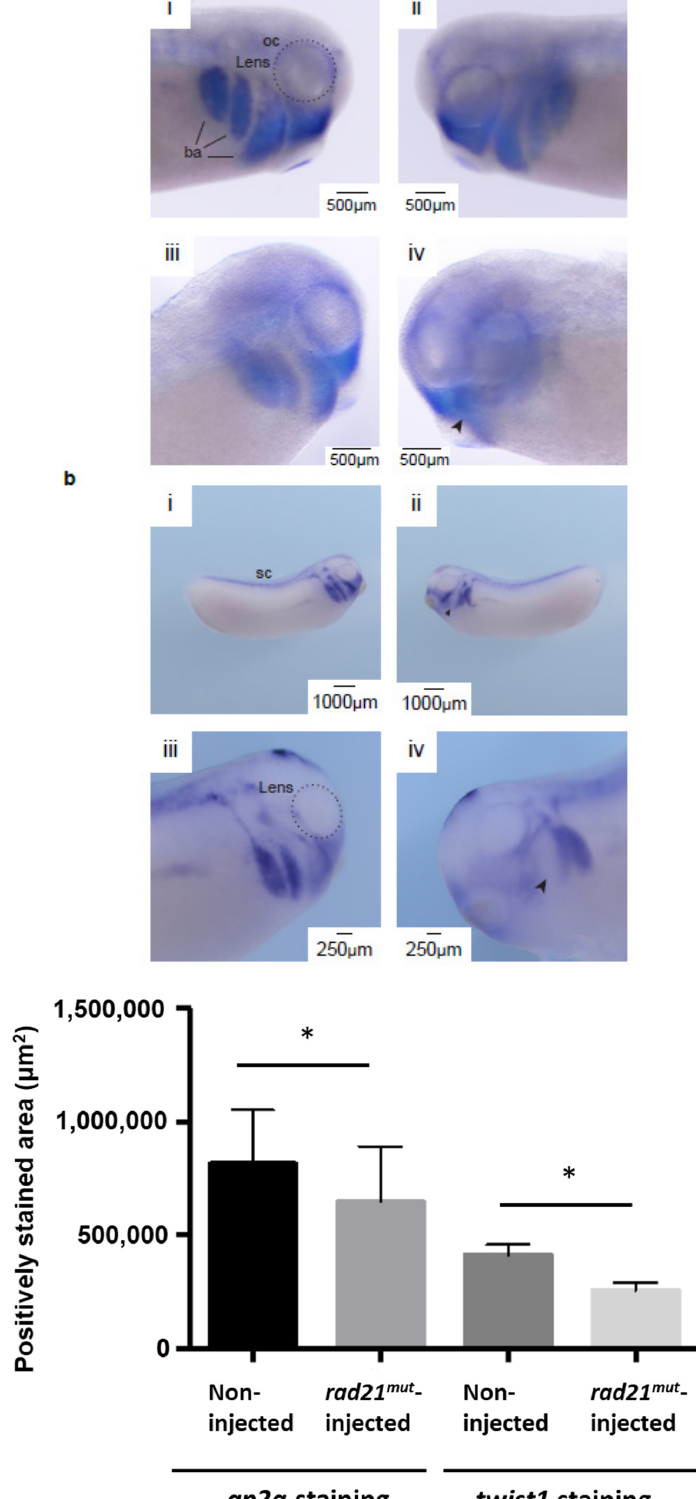
Figure 3. rad21 mut disrupts the migration of neural crest cells (NCCs) in stage-25 Xenopus laevis . ( a ) The in situ hybridization pattern of twist1 was altered in the rad21 mut -injected side. Panel i and ii show twist1 expression on both sides of the same non-injected embryo. The patterns around the optic cup (oc) and the neural crest migration streams into branchial arches (ba) are intact (indicated by a dash circle and dark solid lines, respectively). Panel iii and iv show the non-injected side and the injected side of the same rad21 mut - injected embryo. The optic cup and branchial arch in panel iii are similar to those in panel i and ii, whereas these patterns are disrupted in panel iv. A total of 20 rad21 mut - injected embryos were used, and 18 of them showed disrupted patterns in the rad21 mut - injected side (18/20). ( b ) The in situ hybridization pattern of ap2a is altered in rad21 mut -injected X. laevis embryos. Panel i shows ap2a is highly expressed in the head region and the spinal cord (sc) in the non-injected side. Panel ii shows the ap2a expression pattern is disrupted in the rad21 mut -injected side. Panel iii and iv show higher magnifications of the non-injected side and rad21 mut -injected side of another embryo. Similar to panel ii, disrupted neural crest migration streams are shown in panel iv. A total of 11 rad21 mut - injected embryos were used, and 9 showed disrupted staining patterns in the rad21 mut -injected side (9/11, arrowhead). ( c ) Quantification of the mandibular areas showing positive staining of ap2a and twist1 . Means and standard deviations for three injected sides were analyzed in each group. Statistics was done by using paired t test; * indicates p < 0.05. 2.4. Decreased Periocular Mesenchymes Invading into the Cornea in rad21 mut -Injected X. laevis Embryos Proper cell migration of periocular mesenchymes (POM) is essential for the formation of corneal stroma and keratocytes [35]. Disrupted mesenchymal migration is able to cause eye anterior segment diseases including sclerocornea [36,37]. POM are derived from cranial neural crest cells (CNCs) [38]. As neural crest cell migration during early development was disrupted after rad21 mut injection, we further investigated whether mesenchymes entering the corneal region were also affected. A POM- specific marker, pitx2 , was analyzed by staining during mesenchymes invasion into the corneal matrix at X. laevis developmental stage 41 [11,39,40]. Panel i and iii in Figure 4a show the non-injected sides of two embryos; POMs are stained purple in the cornea regions. In panel ii and iv of Figure 4a, no strong staining signals are observed in the cornea regions, indicating interrupted POMs migration into the cornea in the rad21 mut -injected sides. In all embryos examined, similar staining patterns were observed. We quantified staining in the cornea areas positive for pitx2 and found that 79.5% of the whole cornea areas were pitx2 -positive in the non-injected sides, while only 21.8% of the whole cornea